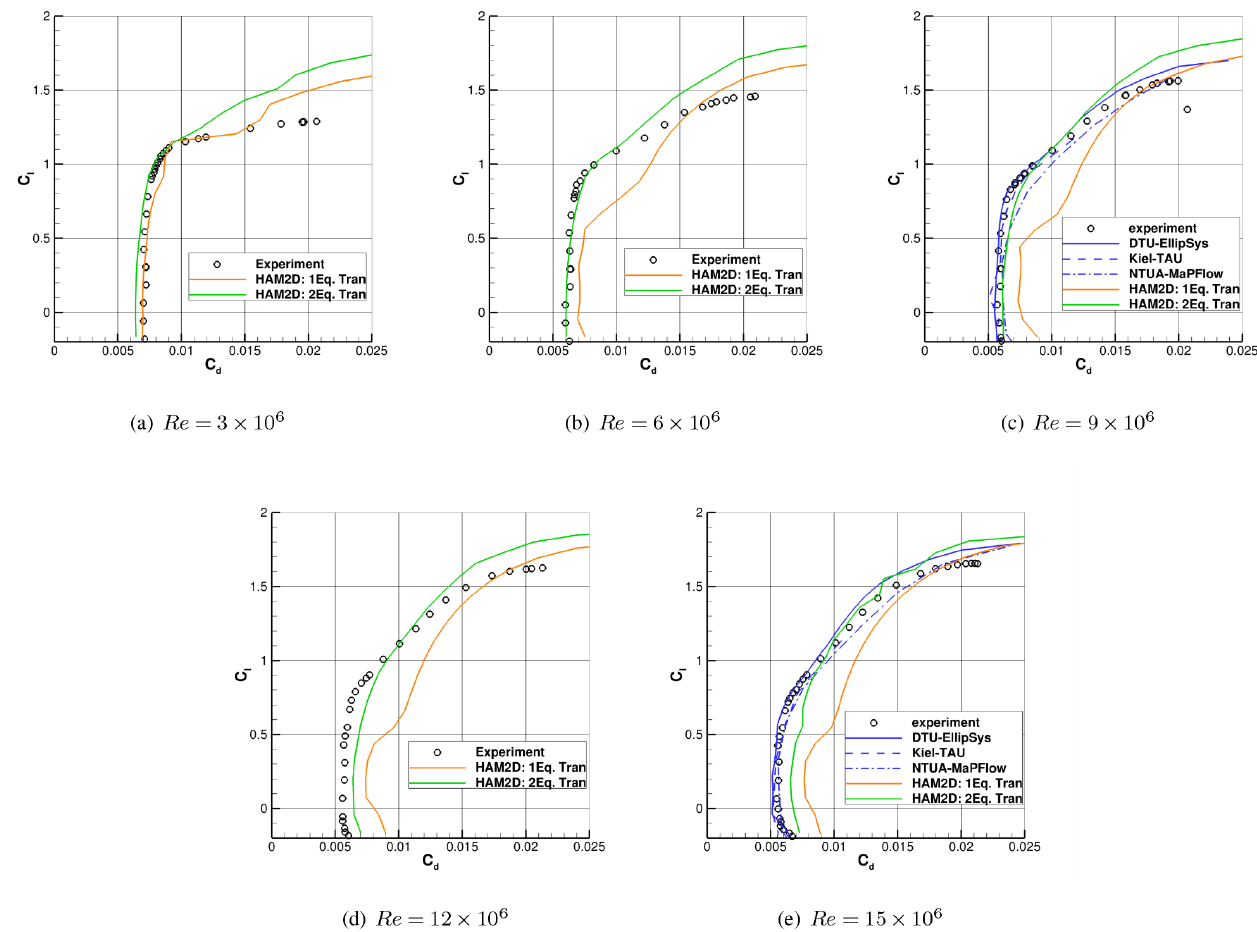
Figure 7. Comparison of drag polar predicted by HAM2D using the one-equation and the two-equation transition models for the DU00-W- 212 airfoil against experimental data from Ceyhan et al. (2017a). Simulation results using various transition models from DTU, Kiel, and NTUA (Ceyhan et al., 2017b) are also shown. All simulations are performed at a free-stream turbulent intensity corresponding to Ti3